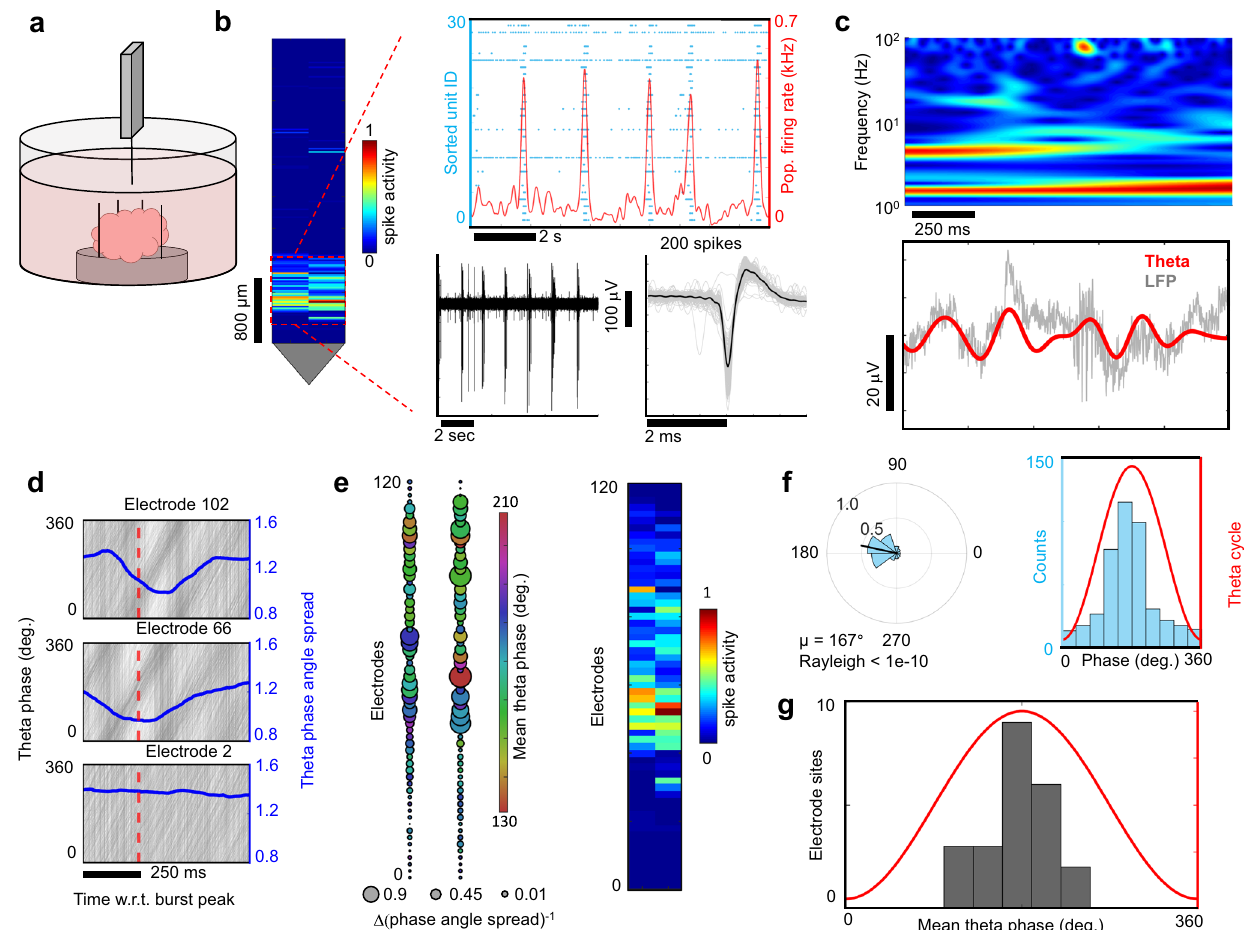
Fig. 9 | Neuropixels CMOS shanks resolves spiking and LFP in the z-plane of a wholebrain organoid. a A Neuropixels high-density CMOSshank was attached to acustom-mademount and controlledbya micromanipulatorinorder tolowerthe shank into an immobilized brain organoid keptat37°Cin BrainPhys media. b Left, spikes(abovea5-rmsthreshold)weredetectedinasubsetofelectrodesnearthetip of the shank. Spike activity is normalized relative to the electrode with the most detected spikes. Top right, raster-plot visualization of single-unit spiking activity (Kilosort2)asshownby the blue dots for each sortedunit. Stereotyped population bursts are visualized as peaks in the population averaged fi ring rate (red line). Bottom right shows the extracellular fi eld potentials (0.3 – 4kHz) generated by a spiking neuron withintheorganoidas measured by the shank. c Top, spectrogram plot oflocal fi eldpotential(LFP) from anelectrode illustratesdominant oscillation power in the theta and delta bands. Bottom, raw LFP (gray line) from the same electrodeoverlaidwiththetheta- fi lteredband(redline). d Thetaphasetraces(gray lines) are shown relative to population burst peak events (red dotted line) reveal